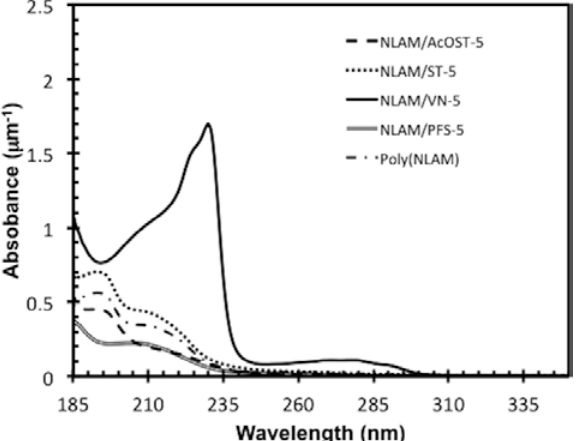
Figure 3. Absorption spectra of NLAM/X (X = controlling co-monomer) copolymers by nitroxide-mediated polymerization (NMP) and poly(NLAM) by conventional free radical polymerization at wavelengths from 185 nm to 350